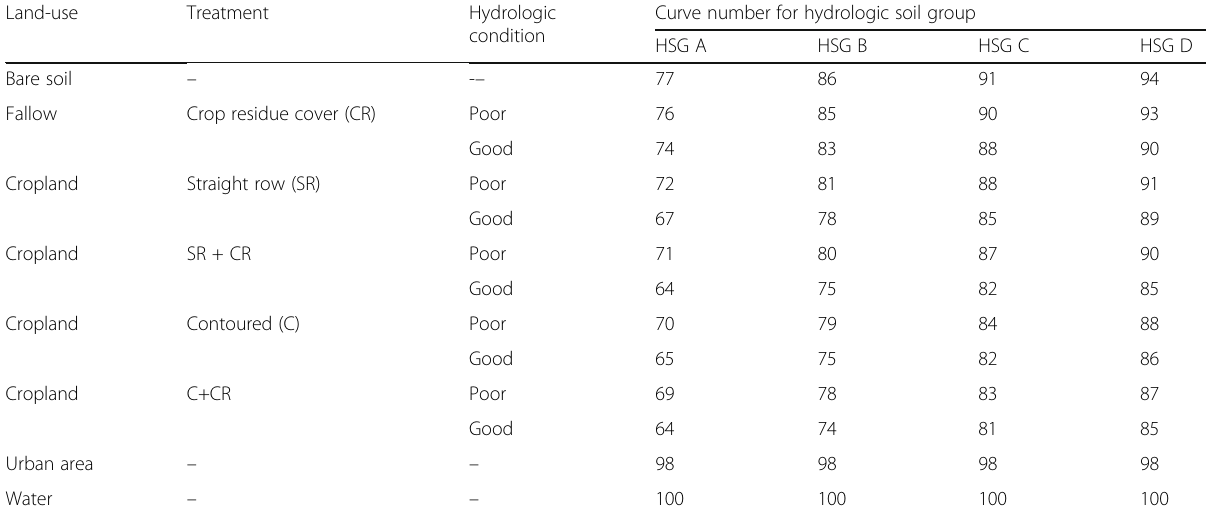
Table 1 Curve number values extracted from published tables listed in NRCS-CN, 1986 (TR-55) handbook manual Land-use Treatment Hydrologic condition